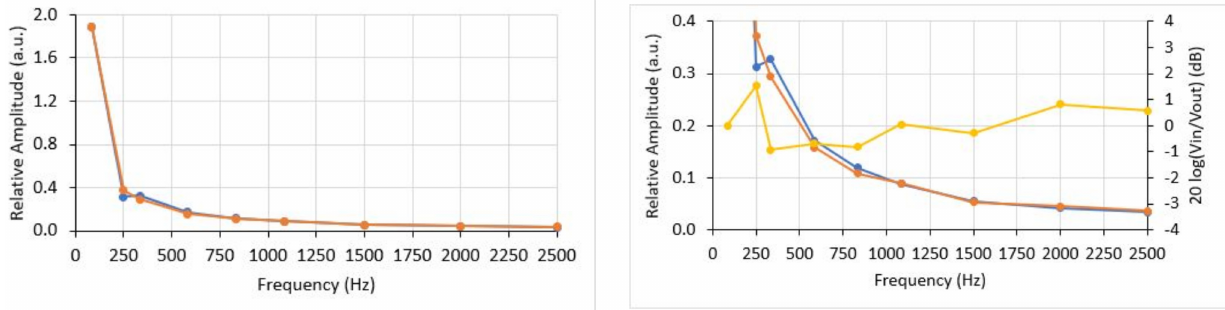
Figure 17. FFT of input (blue line) and output (red line) of the OVT. The graph on the ( right ) is an amplification of the lower portion of the graph on the ( left ). The yellow line is the OVT response in